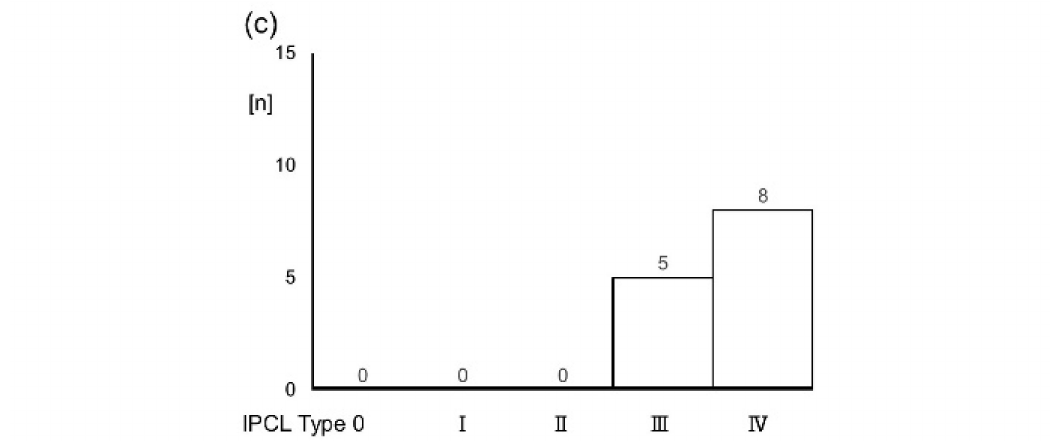
Figure 6. ( a ) OLP lesions were most commonly low-grade (I–II) IPCL patterns (75.0%). ( b ) Clinical oral leukoplakia showed various type of IPCL, including nine (29.0%) type 0, 14 (45.1%) type I, three (9.7%) type II, three (9.7%) type III, and two (6.7%) type IV. ( c ) OSCC were composed of five (38.5%) type III and eight (61.5%) type IV. The distribution of IPCL varied according to the disease. There were statistically significant differences (Kruskal–Wallis test, p <